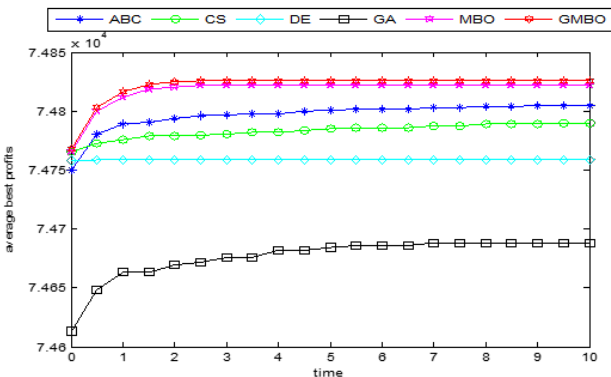
Figure 22. The convergence graph of six methods on KP10 in 10 seconds.